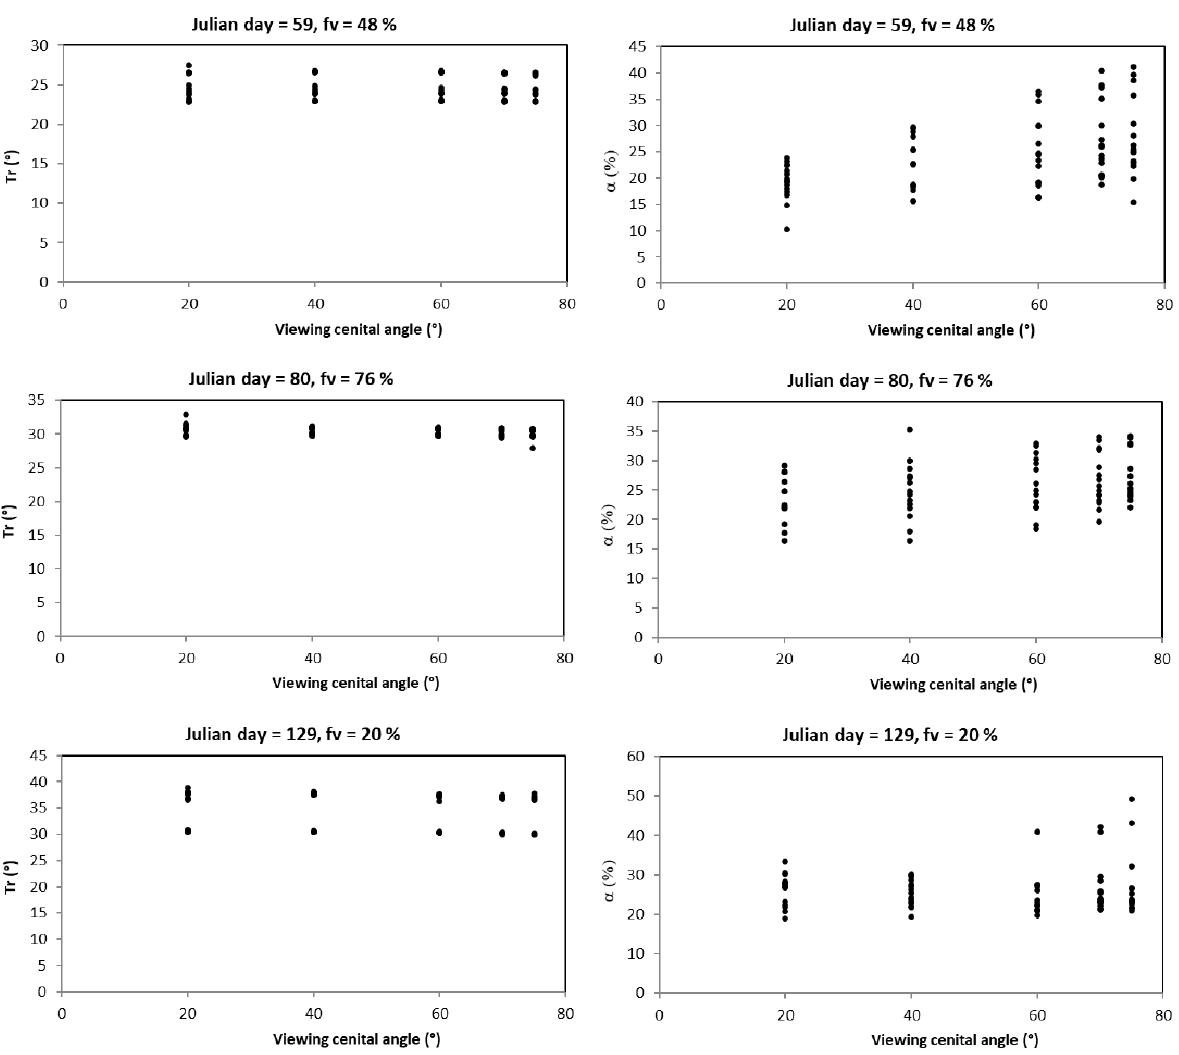
Figure 8. Variation of radiative temperature and albedo measurements in PH4 (chickpea) on three different days during the crop growth cycle.